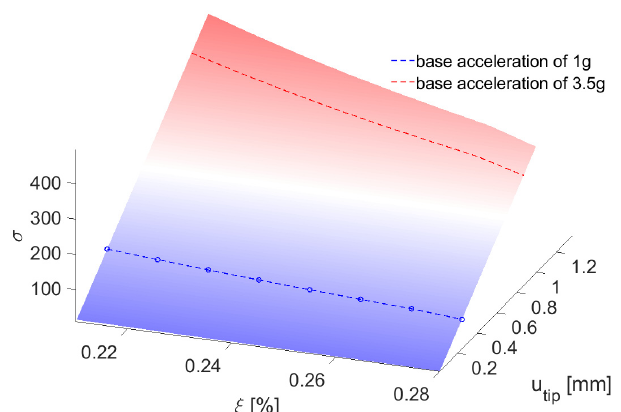
Figure 9. Equivalent stress amplitude map for FCC specimens.